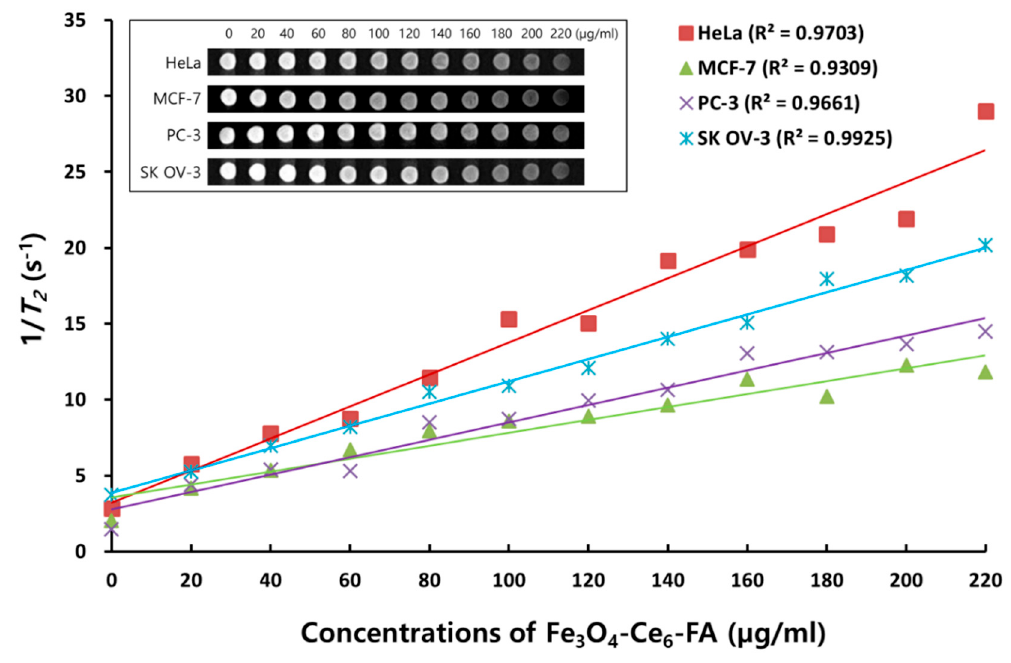
Figure 3. The T 2 relaxation rate and magnetic resonance (MR) images of FCF NPs in various cancer cells. Each cancer cell was treated with different FCF NP concentrations and incubated for 2 h in the dark. MR images were acquired with a 3.0 Tesla MRI instrument (SIEMENS MAGNETOM Skyra, A Tim + Dot system). The inner box shows the T 2 -weighted MR images of each cancer cell. HeLa: cervical adenocarcinoma; MCF-7: breast adenocarcinoma; PC-3: prostate adenocarcinoma; and SKOV-3: ovary adenocarcinoma cells.